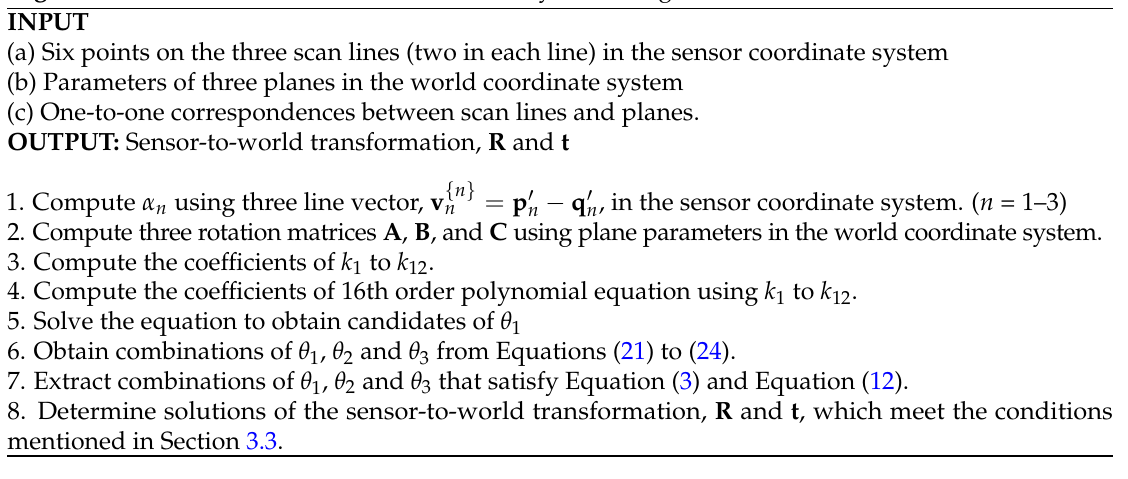
Algorithm 1 6-DOF Pose Estimation of a Lidar System using Three